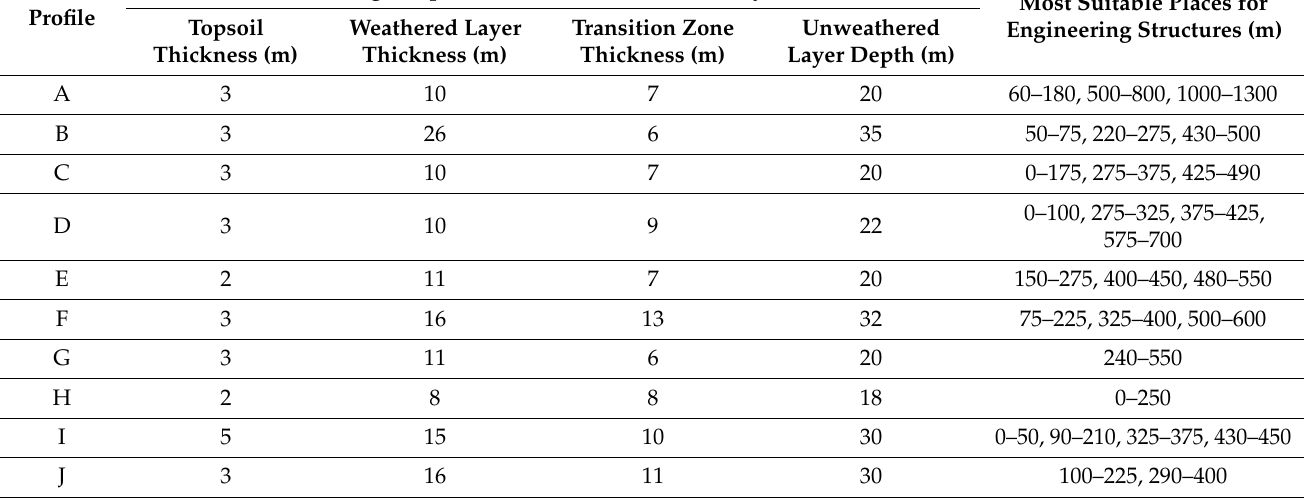
Table 2. Results obtained from the interpreted ERT models suggesting the most suitable places for the construction of engineering structures, including average thickness/depth of the topsoil layer, weathered layer, weathered/unweathered transition zone and unweathered layer along each